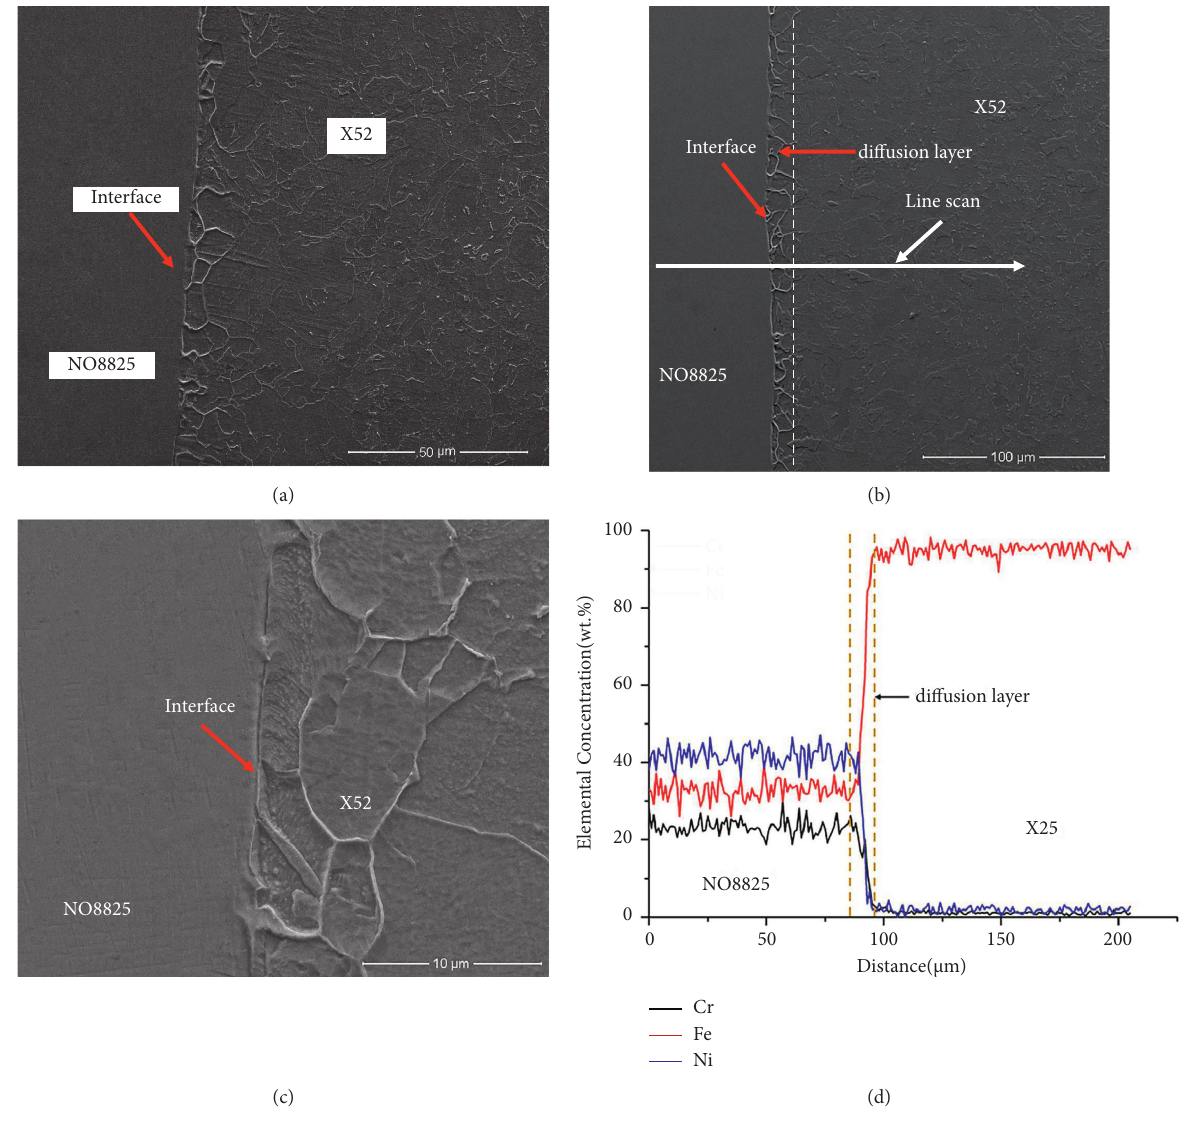
Figure 2: Morphologies at the interface of NO8825/X52 composite plate: (a) enlarged view of the X52 carbon steel side, (b) the cross-section